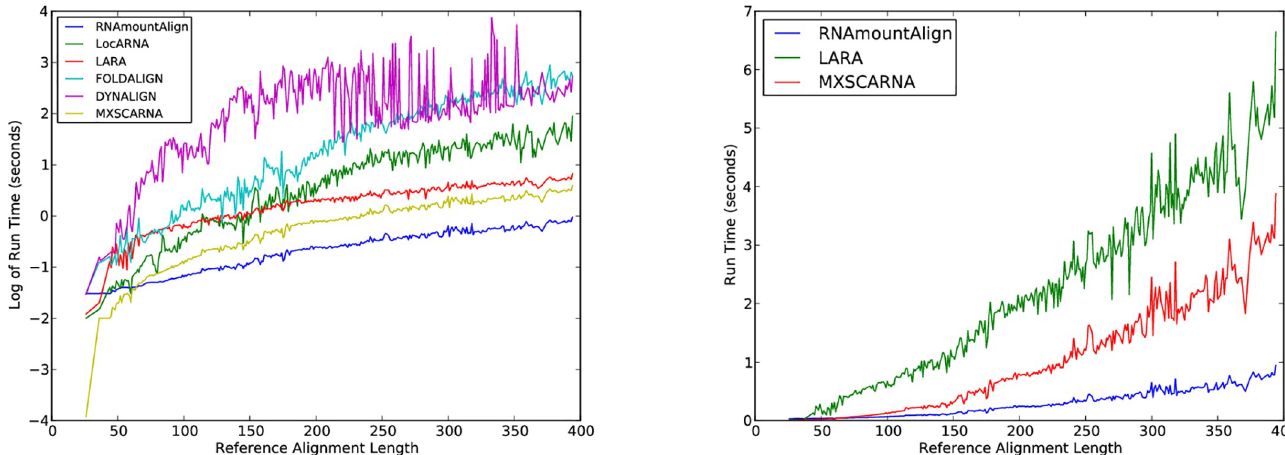
Fig 4. Run time of pairwise global alignment for RNAmountAlign , LocARNA , LARA , FOLDALIGN , DYNALIGN , and MXSCARNA . (Left) The log base 10 run time is shown as a function of reference alignment length for pairwise alignments in the BRAliBase 2.1 K2 database used for benchmarking. Moving averages taken for centered, symmetric windows of size 51. (Right) Actual run time for RNAmountAlign , LARA and MXSCARNA on the same data. Unlike the left panel the actual run time is shown, rather than log run time, without any moving average